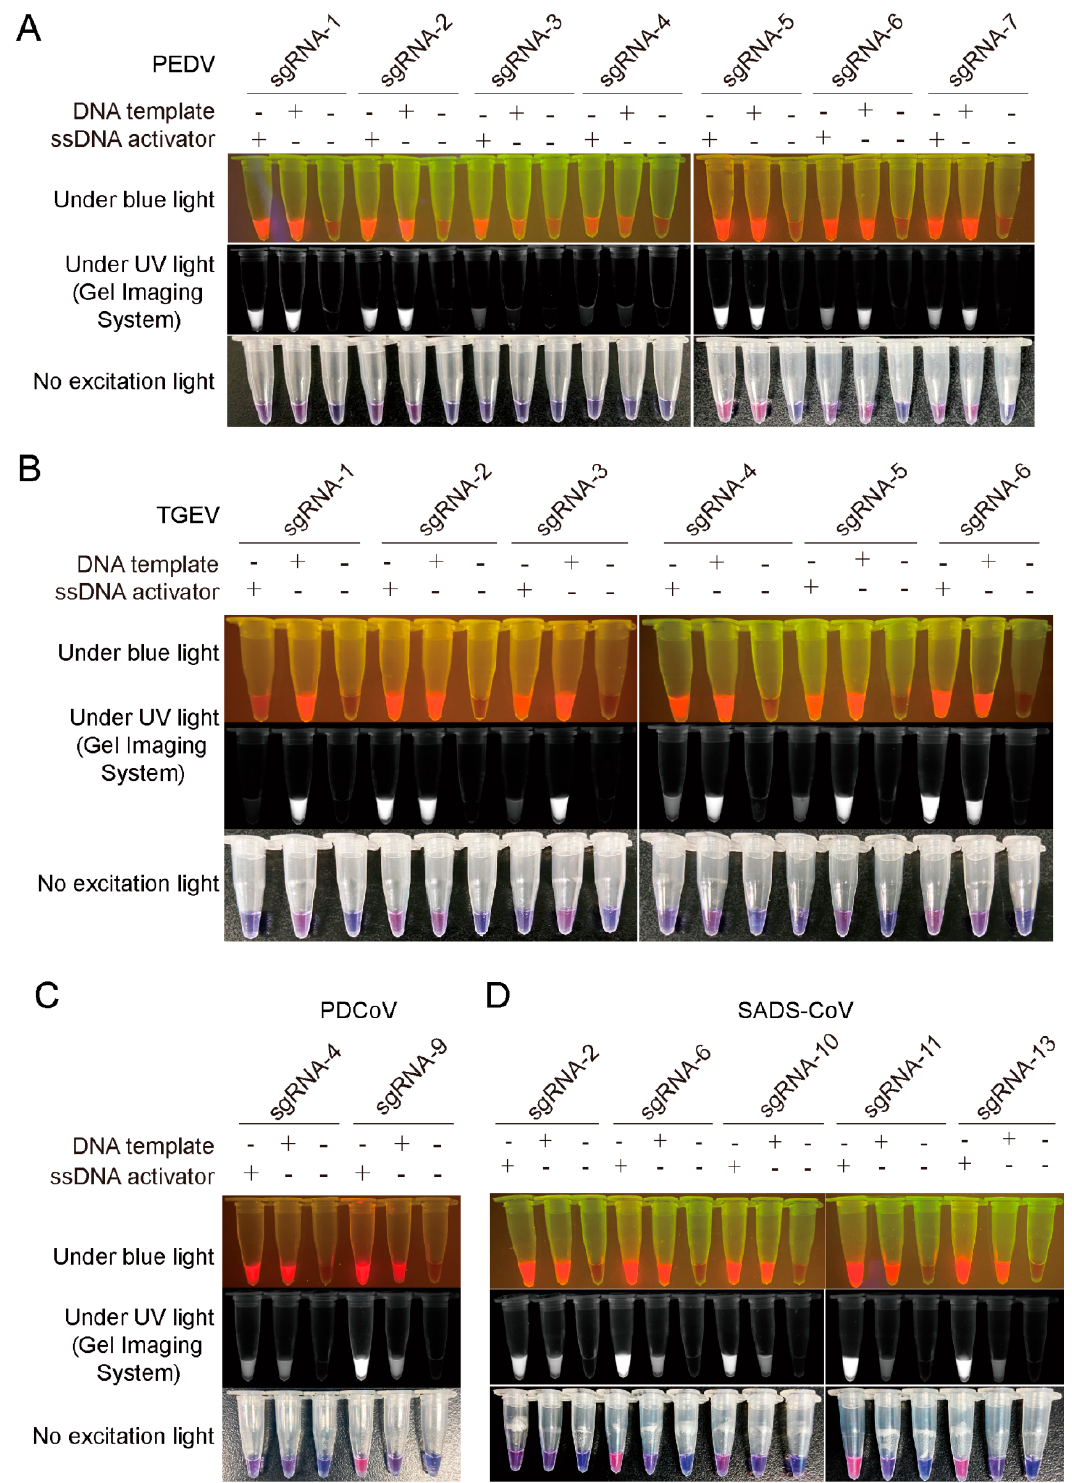
Figure 1. Screening of highly active sgRNAs for detection of PEDV, TGEV, PDCoV, and SADS-CoV. Identification of the highly active sgRNA targeting PEDV ORF3 gene ( A ), TGEV N gene ( B ), PDCoV N gene ( C ), and SADS-CoV N gene ( D ) by CRISPR/Cas12a cleavage assay; DNA template represents the amplification fragment of ORF3 or N gene as the template; ssDNA activator represents the complementary single-stranded DNA of the sgRNA. No excitation light stands for white light. PEDV, porcine epidemic diarrhea virus; TGEV, transmissible gastroenteritis virus; PDCoV, porcine deltacoronavirus; SADS-CoV, swine acute diarrhea syndrome coronavirus.